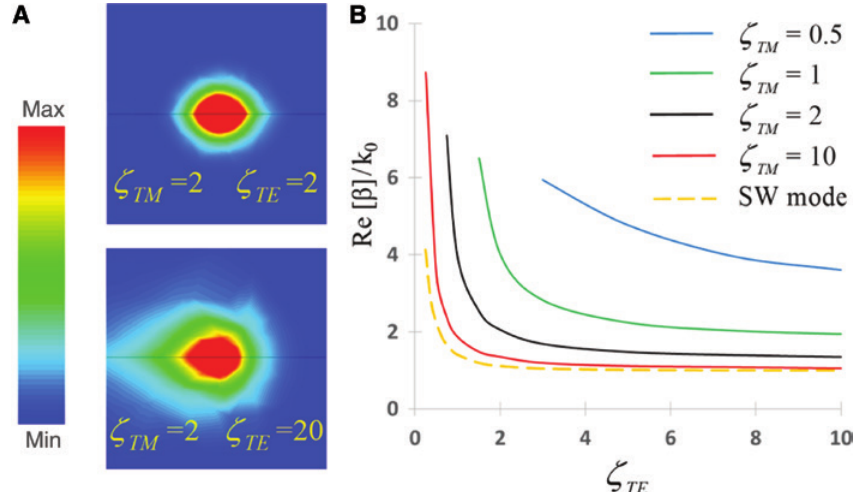
Figure 5: Numerical simulation of the quasi-line mode confinement properties. (A) Distribution of the E-field magnitude over a cross-sectional area within the transverse plane to the propagation direction of the line mode (top) and a quasi-line mode (bottom), and (B) normalized propagation constant (confinement factor) of the quasi-line mode at differ- ent surface impedance values in case of non-complementary and lossless impedance surfaces across the line interface and comparison with conventional surface wave (SW) mode. The spin orientation can be understood from Figure 6A, which depicts the rotation of both E and H field vectors at an angle with respect to the surface. The value of the local spin density (in units of ħ per photon) is deter-